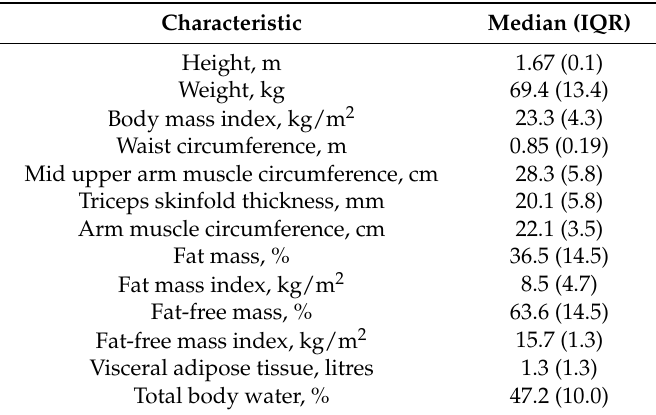
Table 5. Anthropometric and body composition measurements of the